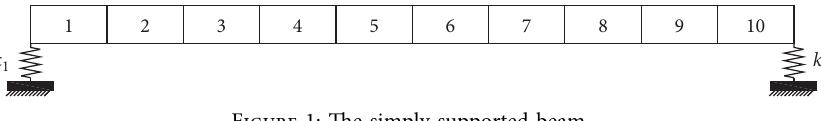
Figure 1: The simply supported